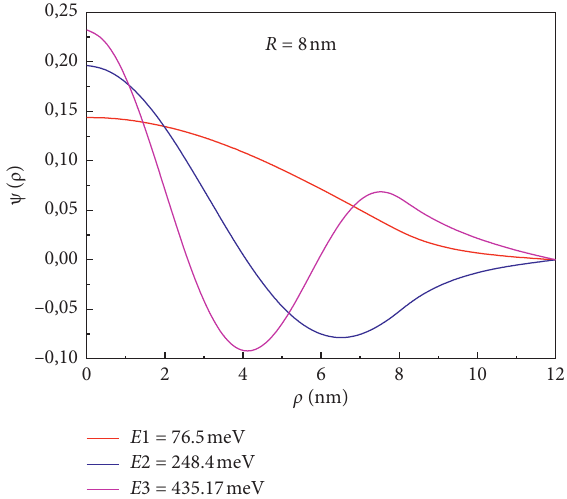
Figure 7: The dependence of the radial wave function of an electron on the radius of a cylindrical quantum wire with a finite